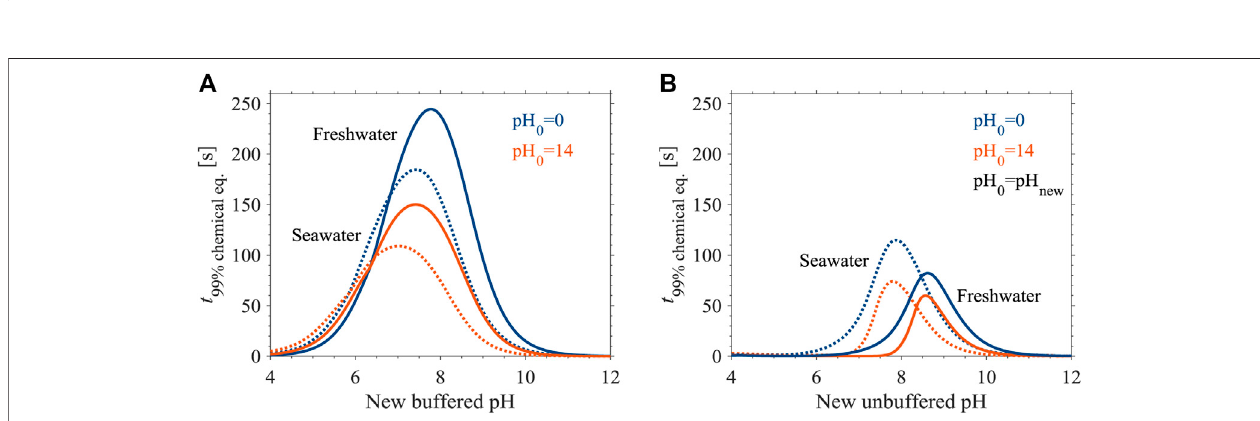
Frontiers in Earth Science |